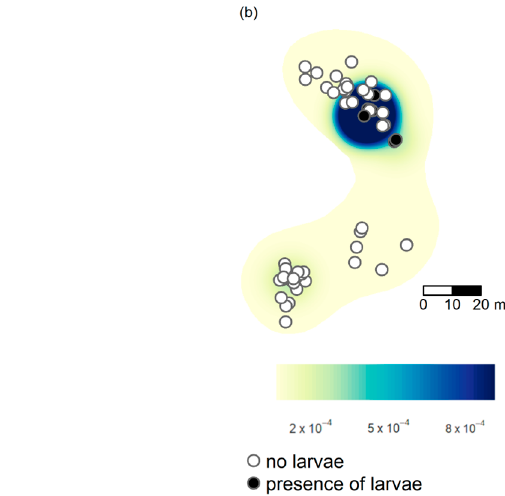
posed locations of Ma. teleius larvae, in Kraków ( a ), or Kosy ń ( b ), at the end of larval development.